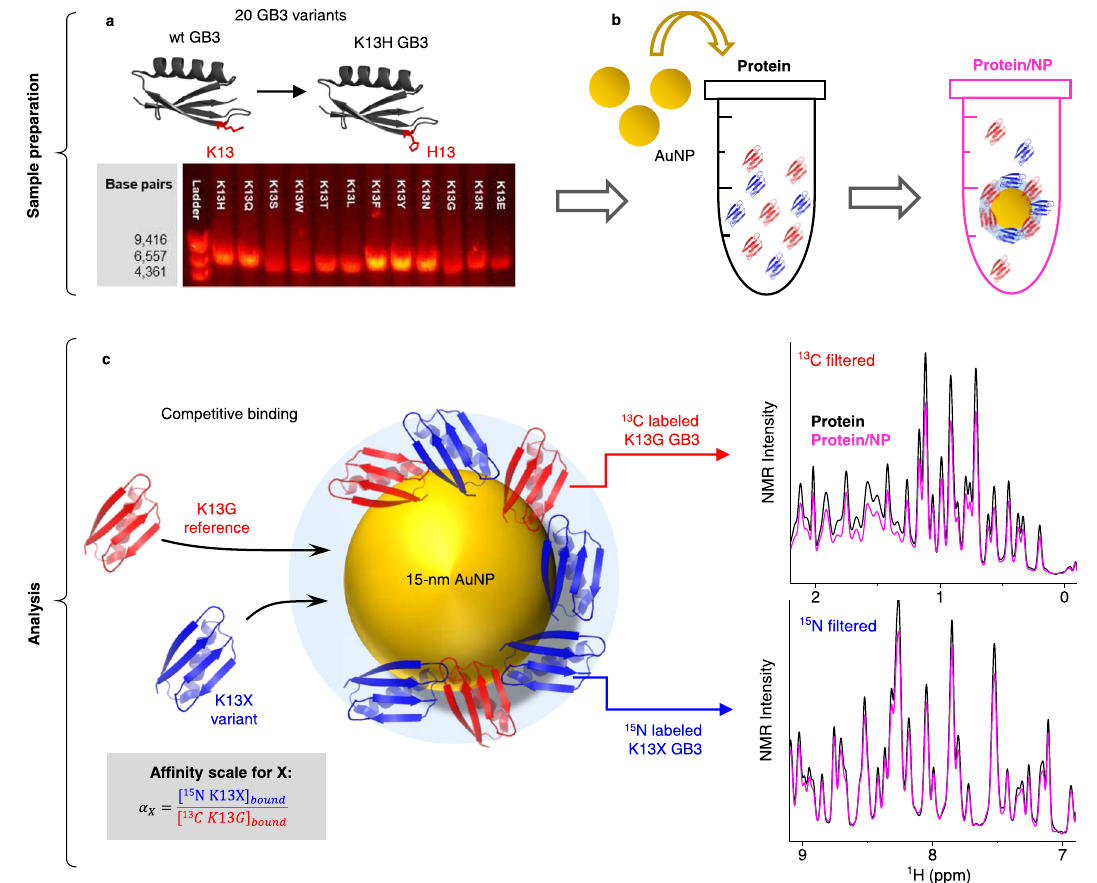
Fig. 1 | Determination of af fi nity scales for 20 amino acid residues with host- guestcompetitivebindingexperiments.a MutagenesisofK13intoeachofthe20 amino acids with histidine (H13) as an example. The agarose gel electrophoresis shows several examples of PCR products for GB3 mutants. b Preparation of com- petitive binding experiments. Two GB3 variants (protein) are mixed before adding AuNPs (protein/NP sample), and a protein corona is formed upon adsorption. c NMRanalysisforquanti fi cationofbindingcapacityofeachvariant.Thereference